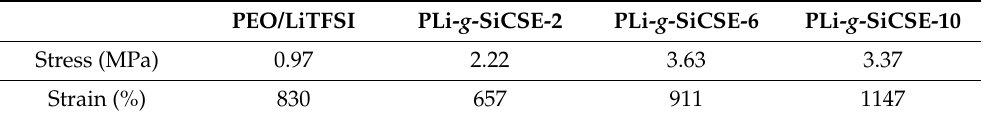
Figure 7. ( a ) Stress-strain measurement of PLi- g -SiCSEs, ( b ) Stress-strain curves of the prepared CSEs membranes containing PEO/LiTFSI and different amounts of PLiSSPSI- g -SiO 2 nanoparticles. Table 1. Mechanical properties of the prepared CSEs membranes containing PEO/LiTFSI and different amounts of PLiSSPSI- g -SiO 2